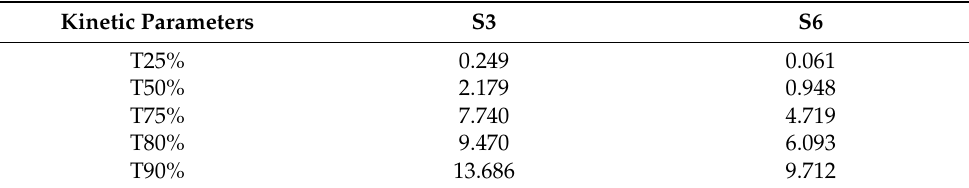
Table 3. Time (hours) necessary to release 25, 50, 75, 80, and 90% of IBU loaded in nanoconjugate hydrogels S3 and